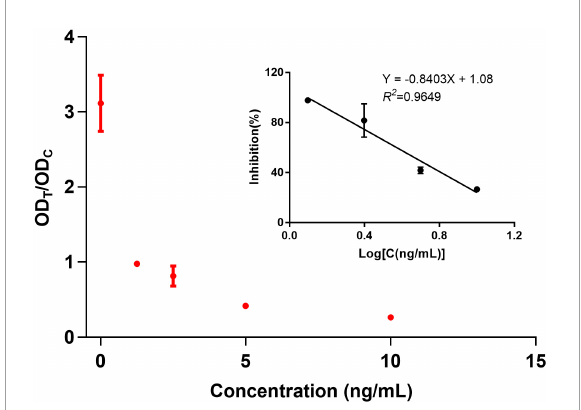
FIGURE4 Standard curve of the colloidal gold immunochromatographic test